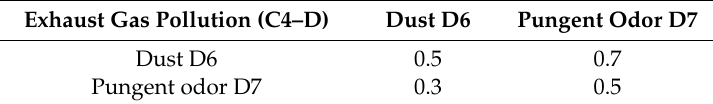
Table 9. Layer judgment matrix